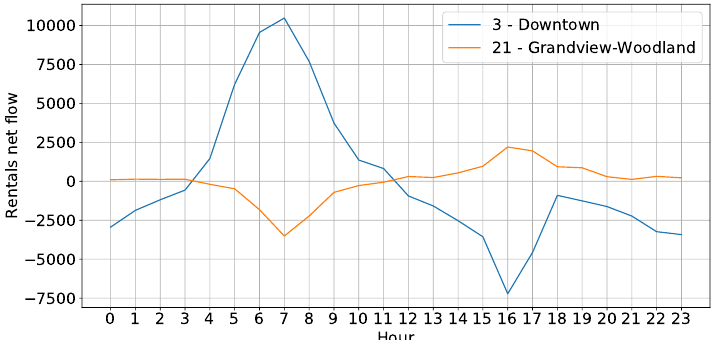
Figure 4. Total net flow in September 2017 for Downtown (neighborhood 3) and Grandview-Woodland (neighborhood 21) over different hours of the